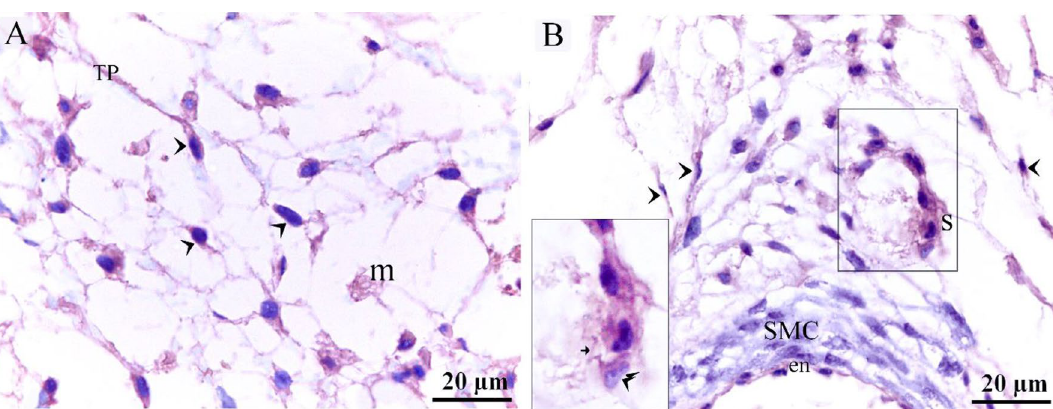
Figure 5. Immunohistochemical staining of the neck skin of quail embryos at day 8 using CD34. ( A ) CD34 + ve TCs (arrowheads) located around the macrophages (m). ( B ) CD34 + ve TCs (arrowheads) located around the blood vessel that consisted of endothelial cell (en) and smooth muscle cell (SMC). CD34 + ve TCs (double arrowheads) were also located around the sprouting endothelial cells (s).